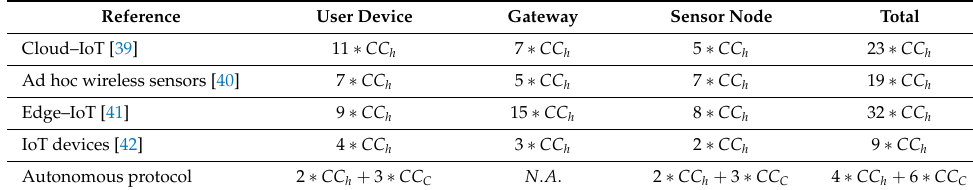
Table 5. Protocol computation cost